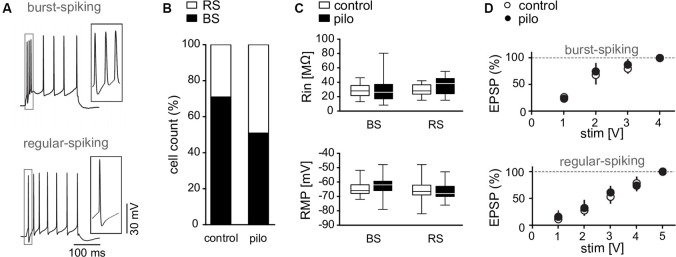
Membrane properties of subicular pyramidal cells. (A) Discharge behavior of RS and BS pyramidal cells upon depolarizing current pulses (300 pA). (B) Cell count of burst spiking (BS) and regular spiking (RS) fractions in control and pilocarpine-treated animals showing a decreased fraction of BS cells in pilocarpine-treated animals (Control BS: 71%, Control RS: 29%, n = 69; BS Pilo: 50.9%, RS Pilo: 49.1%, n = 75; p = 0.01, Fischer’s exact test). (C) Input resistance (Control BS: Rin = 28.5 ± 2.1 MΩ, n = 19, Pilo BS: Rin = 29.1 ± 3.1 MΩ, n = 29, p = n.s.; Control RS: Rin = 30 ± 1.8 MΩ, n = 17, Pilo RS: Rin = 36.2 ± 2.9 MΩ, n = 23, p = n.s.) and resting membrane potential (Control BS: RMP = −64.4 ± 1.2 mV, n = 19, Pilo BS: RMP = −62.6 ± 1.2 mV, n = 29, p = n.s.; Control RS: RMP = −66.4 ± 2 mV, n = 17, Pilo RS: RMP = −65.7 ± 1.4 mV, n = 23) of subicular neurons are not different between slices from control and pilocarpine-treated rats. Here shown as box plots with whiskers from minimum to maximum and line at median. (D) Input-output curves of BS and RS cells obtained from control and pilocarpine-treated animals (Control: BS: n = 23, RS: n = 5; Pilo: BS: n = 7; RS: n = 7).